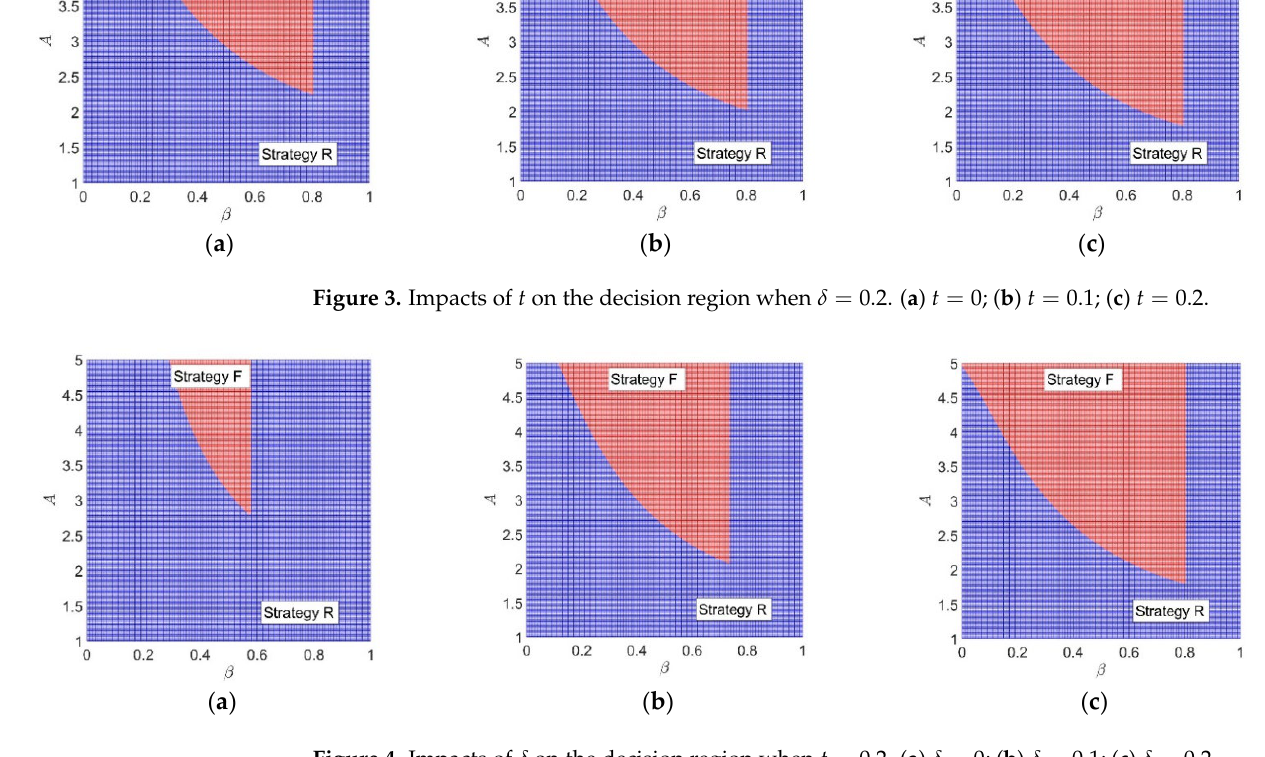
Figure 4. Impacts of δ on the decision region when t = 0.2. ( a ) δ = 0; ( b ) δ = 0.1; ( c ) δ = 0.2.